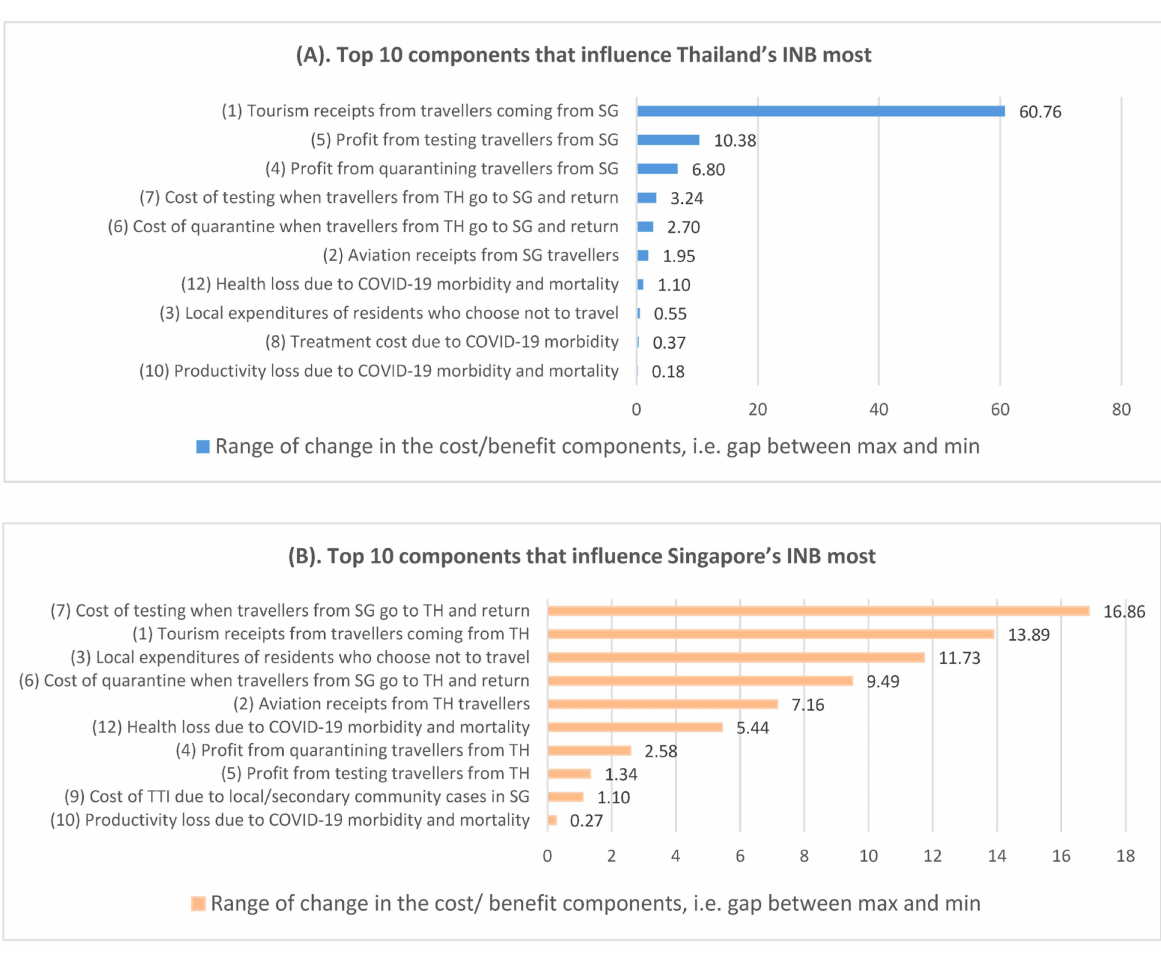
Figure 4. Influential components of incremental net benefit. Abbreviations: COVID-19, coron- avirus disease 2019; SG, Singapore; TH, Thailand; INB, incremental net benefit; TTI, test-trace- isolation. Ten components with the largest range for TH are sorted in ( A ); ten components with the largest range for SG are sorted in ( B ). A larger range indicates a more influential cost/benefit component to the country’s INB. The numbering in front of each cost/benefit component corresponds to that in Table